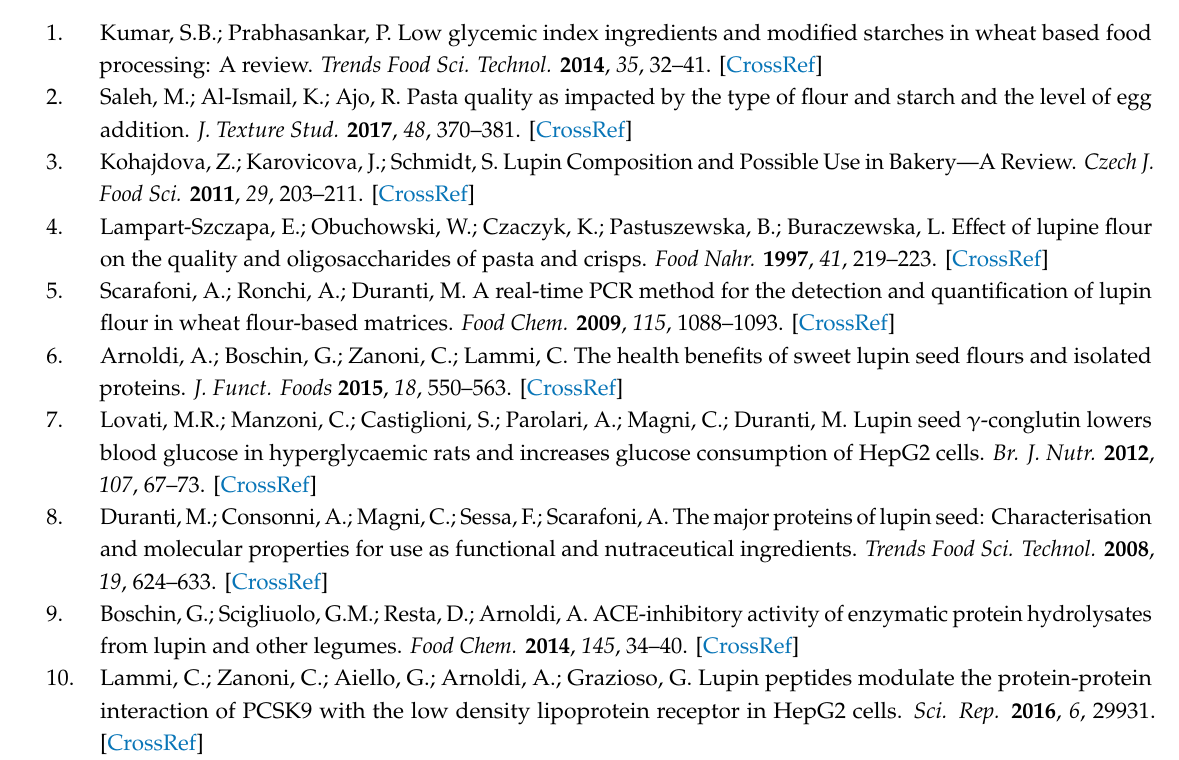
Table S1: HPLC-Chip-ESI-MS / MS based identification of peptides per proteins, respectively, identified in all the 6 analyzed samples. The untargeted MS parameters used are reported in Supplementary